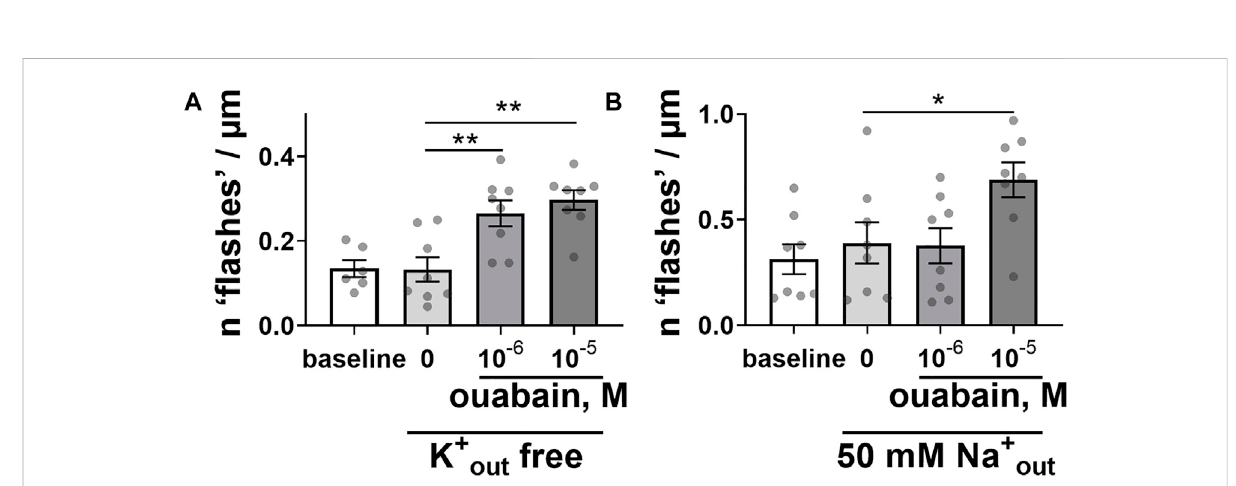
FIGURE 2 ModulationoftheNa,K-ATPaseiontransportactivitydidnotpreventtheability ofouabaintoinduceintracellularCa 2+ fl ashes. Ouabaininduced Ca 2+ fl ashes after omission of K + ions from extracellular solution [ (A) ; n = 6 – 8 of 5 cultures], and a reduction of extracellular Na + concentration to 50 mM [ (B) ; n = 8 of 6 cultures]. * and **, p < 0.05 and 0.01 (one-way ANOVA followed by Sidak ’ s multiple comparisons test).